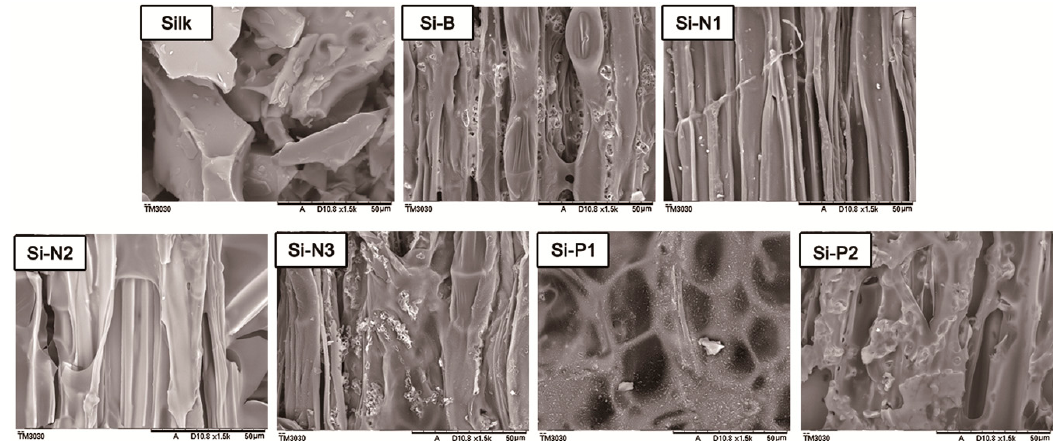
Figure 5. SEM micrographs of the residues left by Silk, Si-B, Si-N 1 and Si-N 2 , Si-N 3 , Si-P 1 and Si-P 2 after the flammability tests.